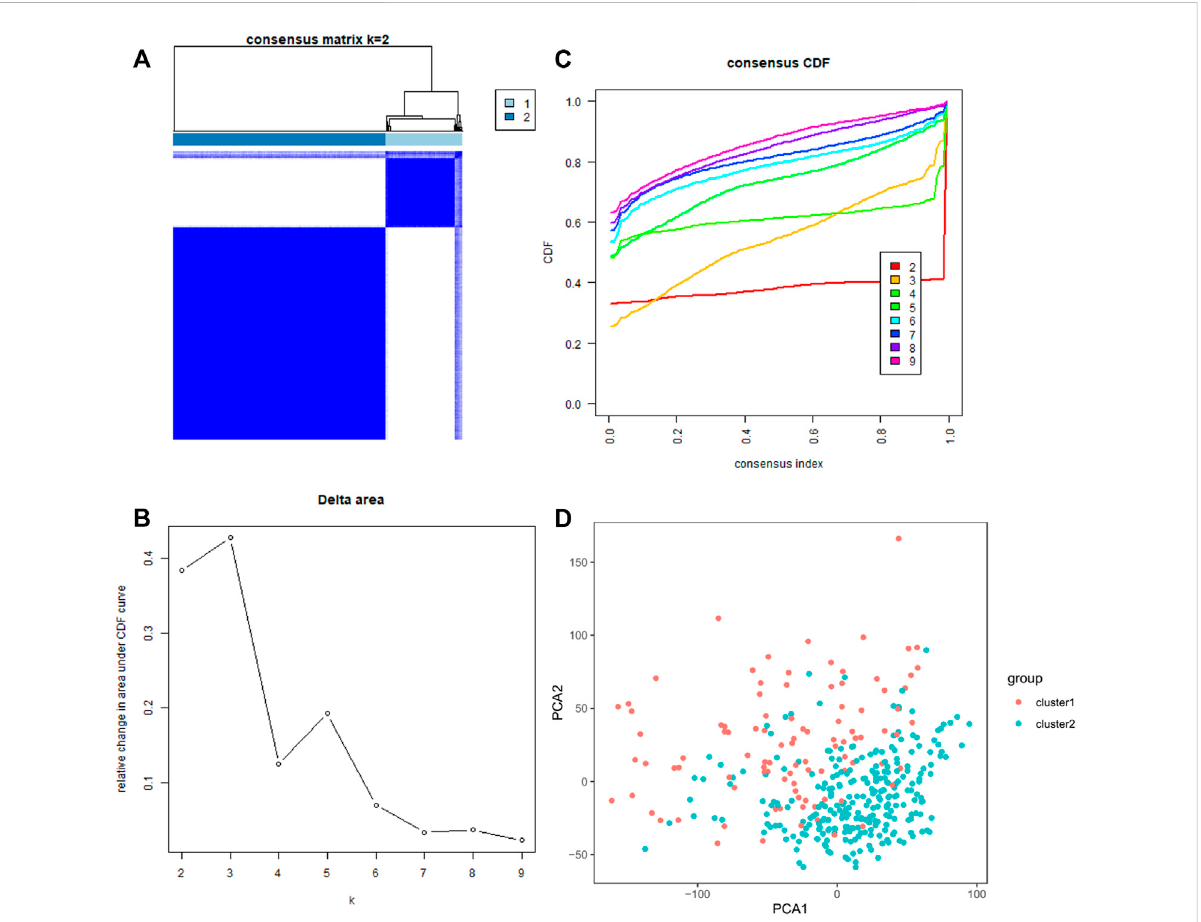
FIGURE 2 Consistent clustering analyses of the HCC. (A) The correlations between subgroups when the number of clusters is k = 2. (B) Cumulative distribution function (CDF) for k = 2 – 9 is displayed. (C) The relative variation of the area under the CDF curve of k = 2 – 9. (D) Principal component analysis of the RNA-seq data. Red dots stand for cluster 1, and cyan dots stand for cluster